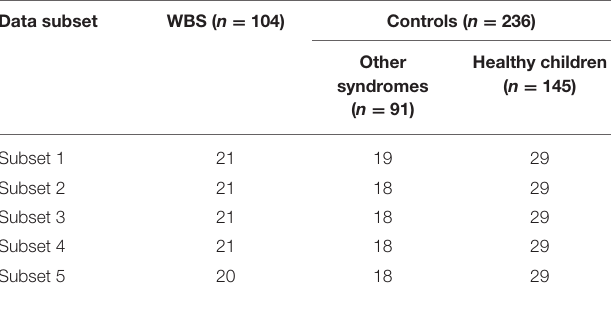
TABLE 4 | Accuracy, precision, recall, F1 score, and AUC of each model.